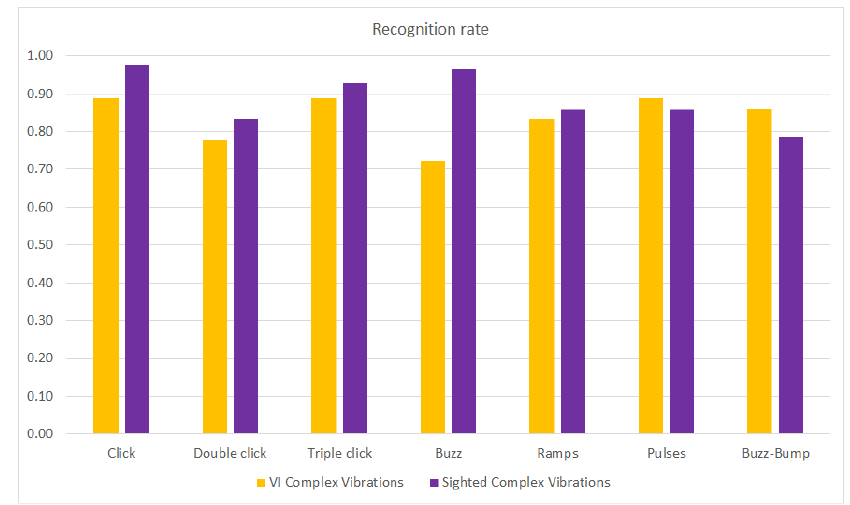
Figure 11. Recognition rate per type of vibration pattern for VI and sighted people.